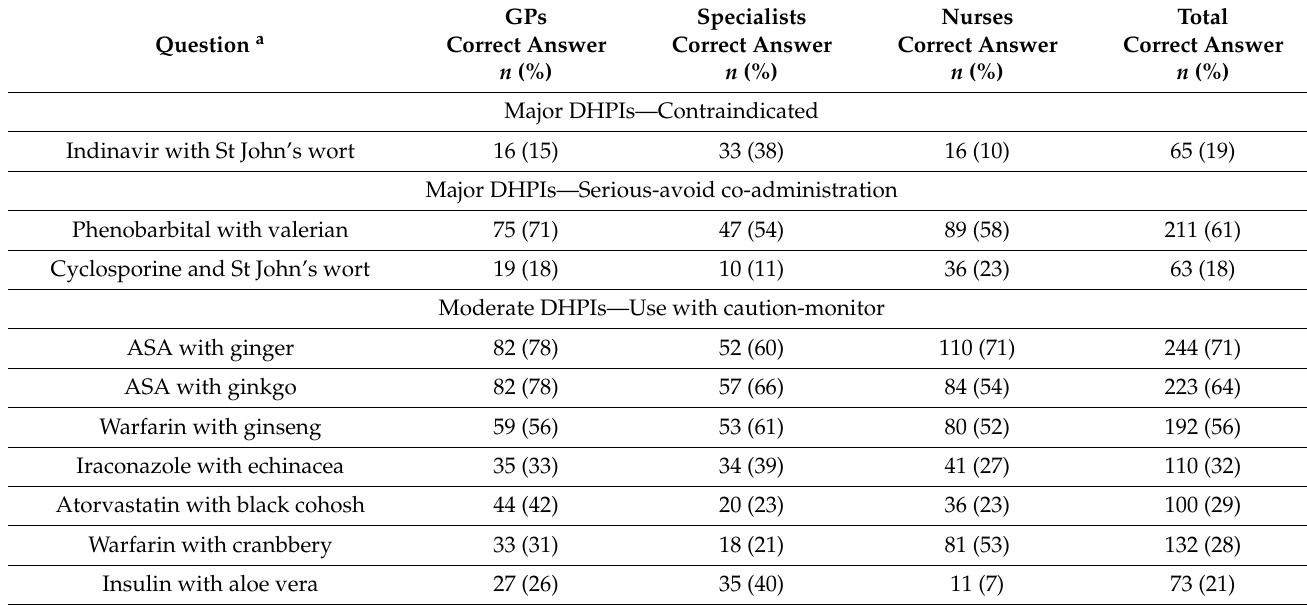
Table 3. Frequency of correct answers about drug-herbal product interactions (DHPIs) among